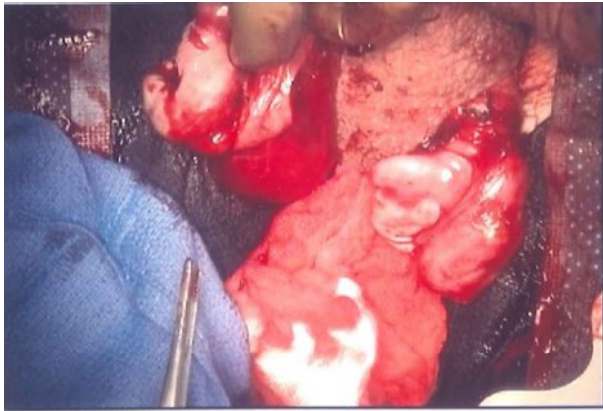
Figure 2. A medial view of the extent of the right testicular